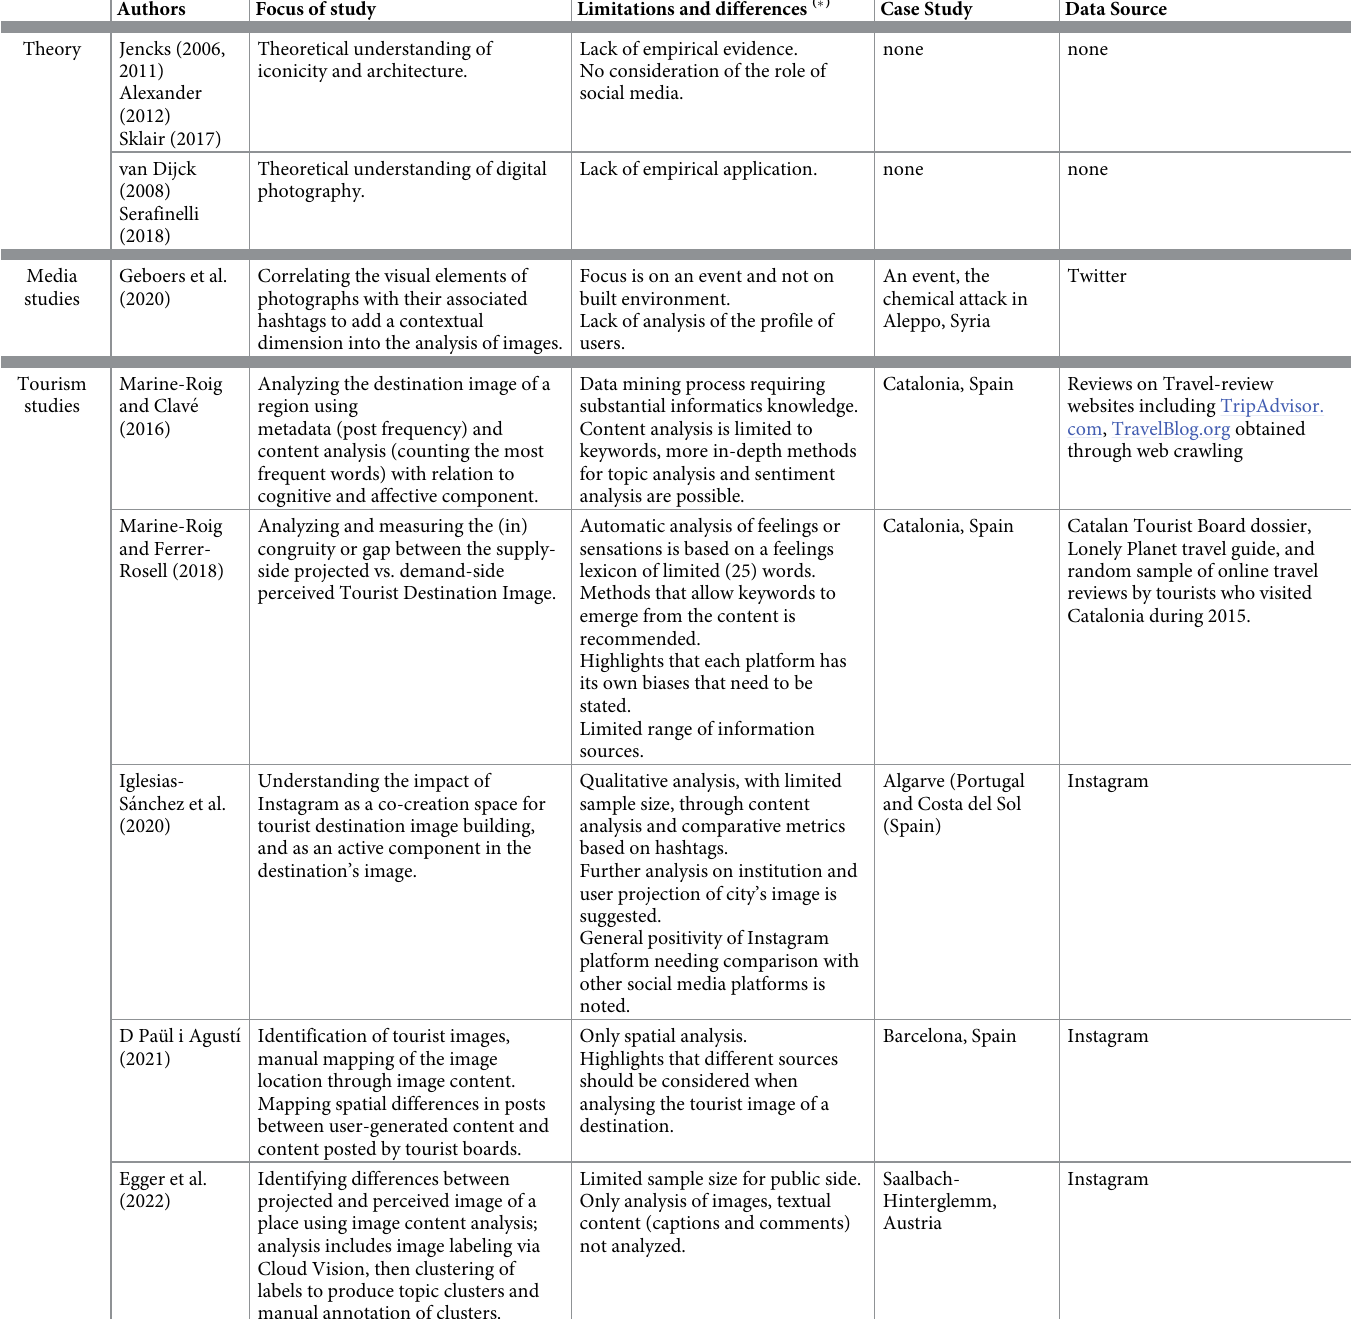
Table 1. Overview of recent research relevant to the study of iconicity and